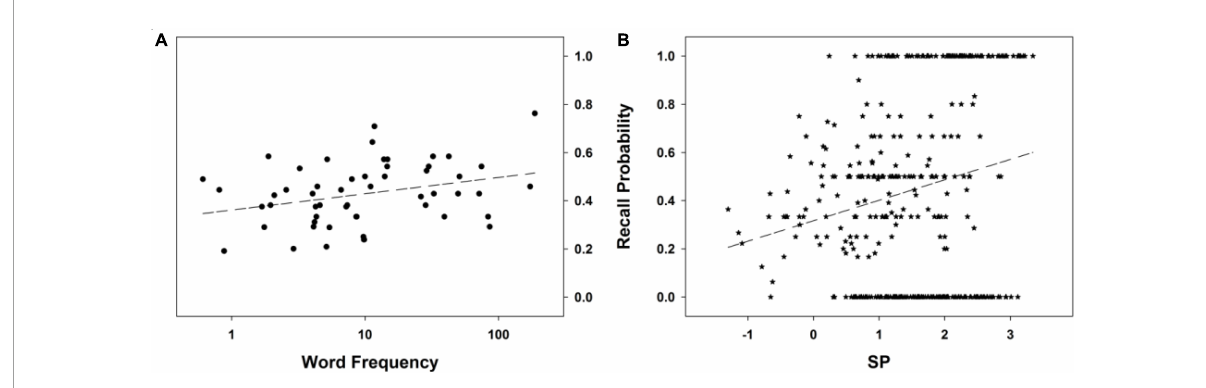
FIGURE4 Free recall probability as a function of (A) log-transformed adult word frequency, and (B) SP. The dashed line stands for the mean probability of the recall